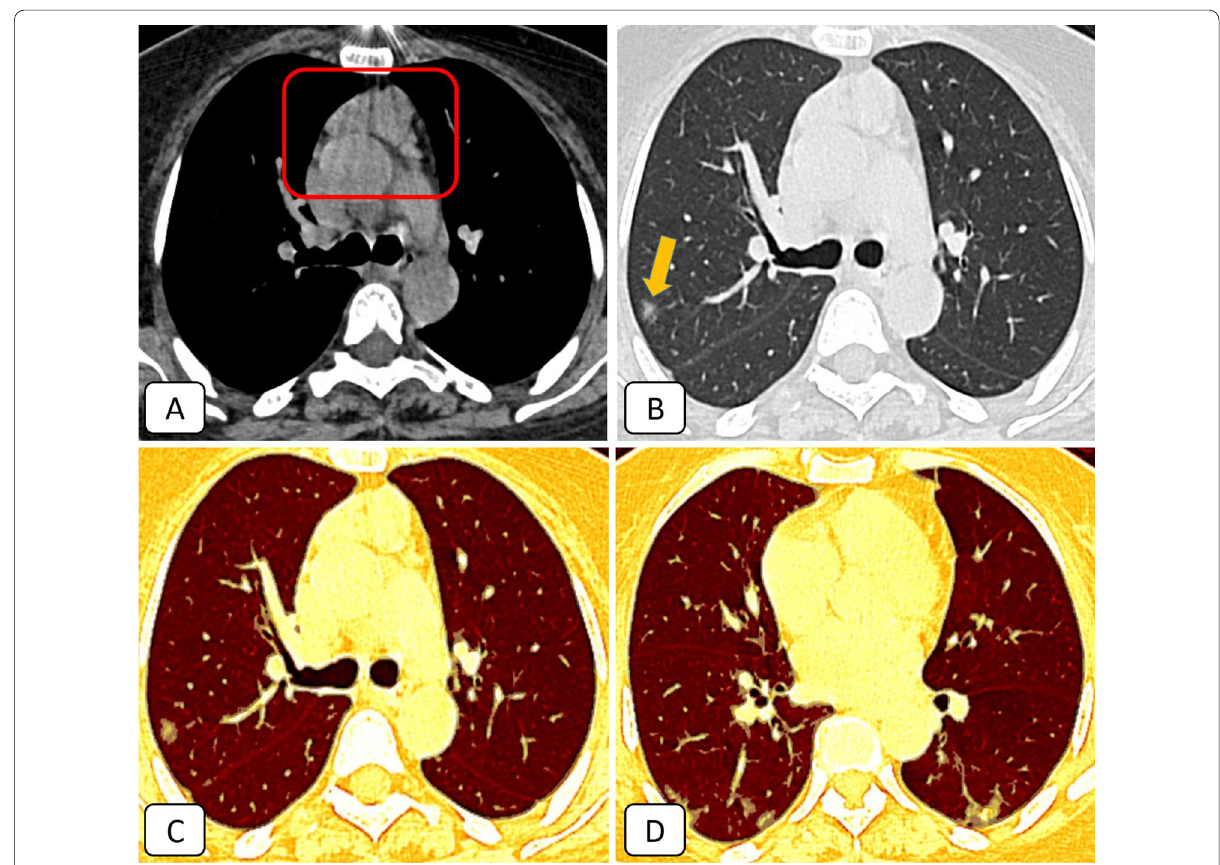
Fig. 4 A 57-year-old female COVID-19 patient complained of loss of taste and smell: A Axial mediastinal window CT showing solid soft tissue replacement of the thymic gland (grade 0) [red square]. B Axial lung window CT showed sub-pleural small ground-glass nodular opacity in the posterior segment of the right upper lobe (orange arrow). C – D Axial 3D volumetry cuts highlighted the bilateral basal small sub-pleural ground-glass opacities. The pathological lung volume was around 1% of the total lung